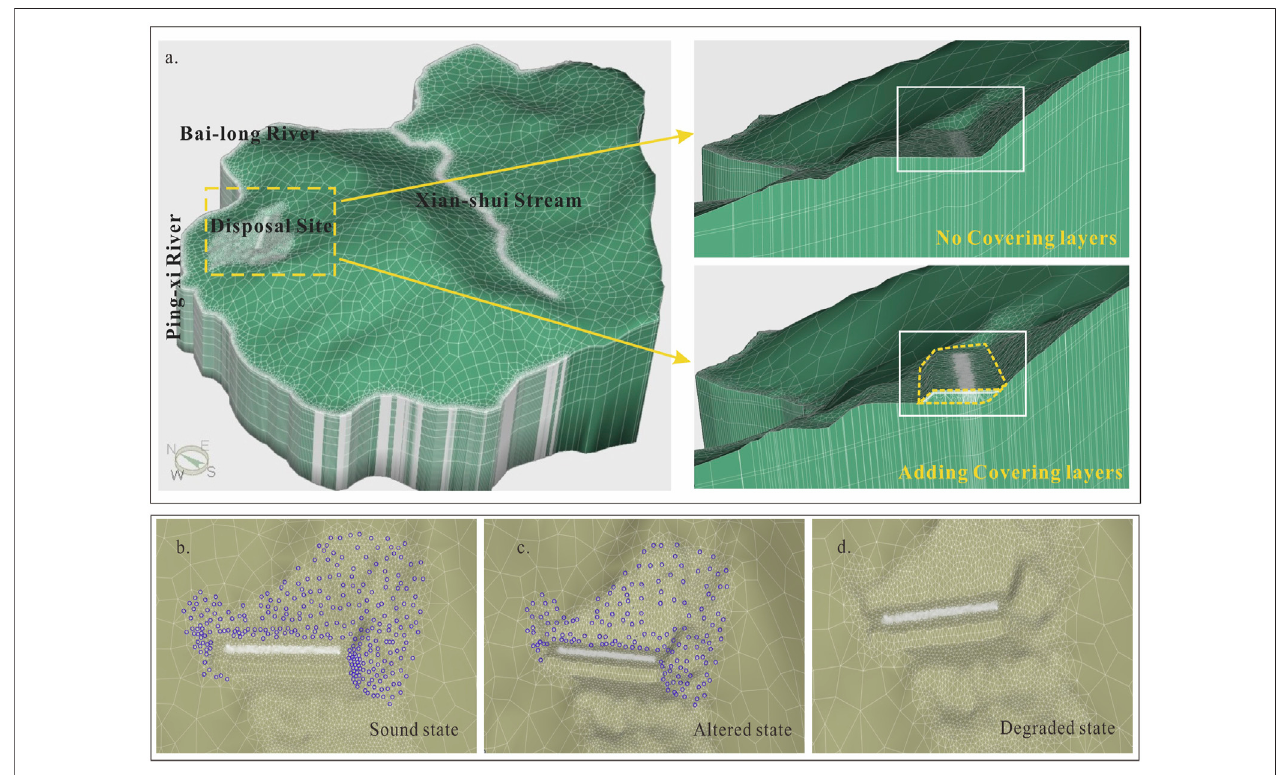
FIGURE 4 | (A) Schematic graphs of space discretization before and after adding covering layers. (B – D) : Simulation of drainage facilities under different states.